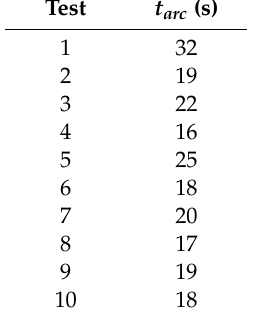
Table 5. Time of the arc faults for repetitive measurements using the Bourns 2049-09 surge